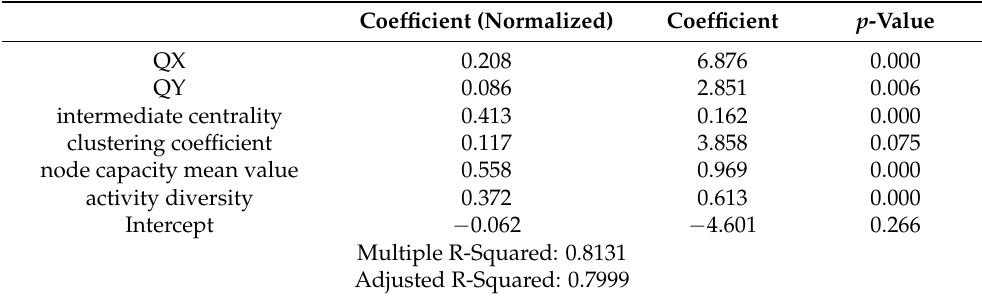
Table 7. Results of multivariate linear regression analysis of the frequency of public space use within affordable housing